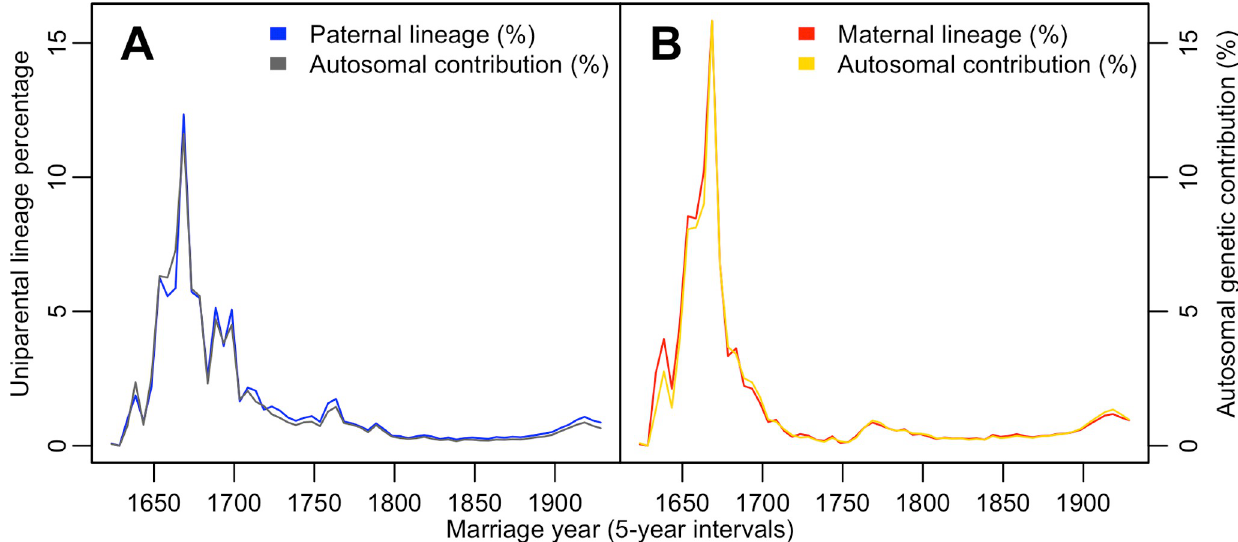
Fig 5. Comparison of “autosomal” GC of immigrant women and men with GC of their maternal and paternal lines ( Nw i ) within the 1931–60 population. The fraction of the immigrant contribution ( y -axis) is expressed per year averaged over five years ( x -axis).